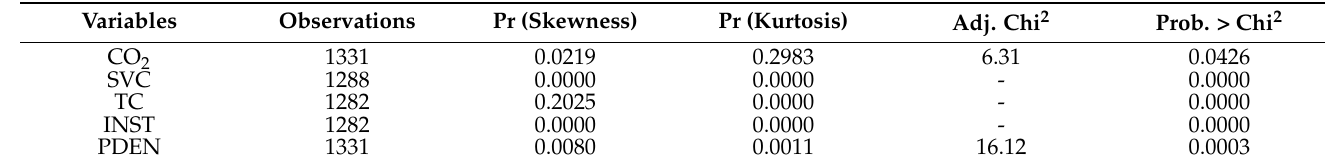
Table 4. Skewness/Kurtosis Tests for Normality.